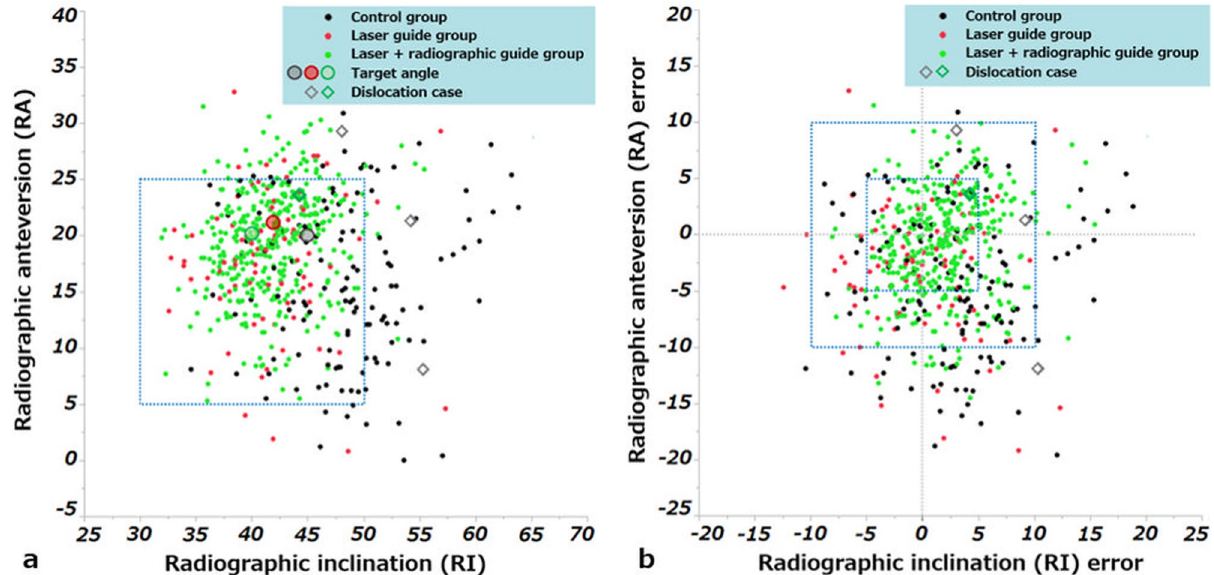
Figure 7. ( a ) Scatter diagram of postoperative radiographic inclination (RI) and radiographic anteversion (RA). Average target angle in each group and dislocation cases are indicated in other shapes. The Lewinnek safe zone (cup inclination 40° ± 10° and anteversion 15° ± 10°) 26 is included for reference. ( b ) Scatter diagram of the RI and RA errors. Dislocation cases are indicated in another shape. The auxiliary square indicates both RI and RA errors within 5° and 10°.